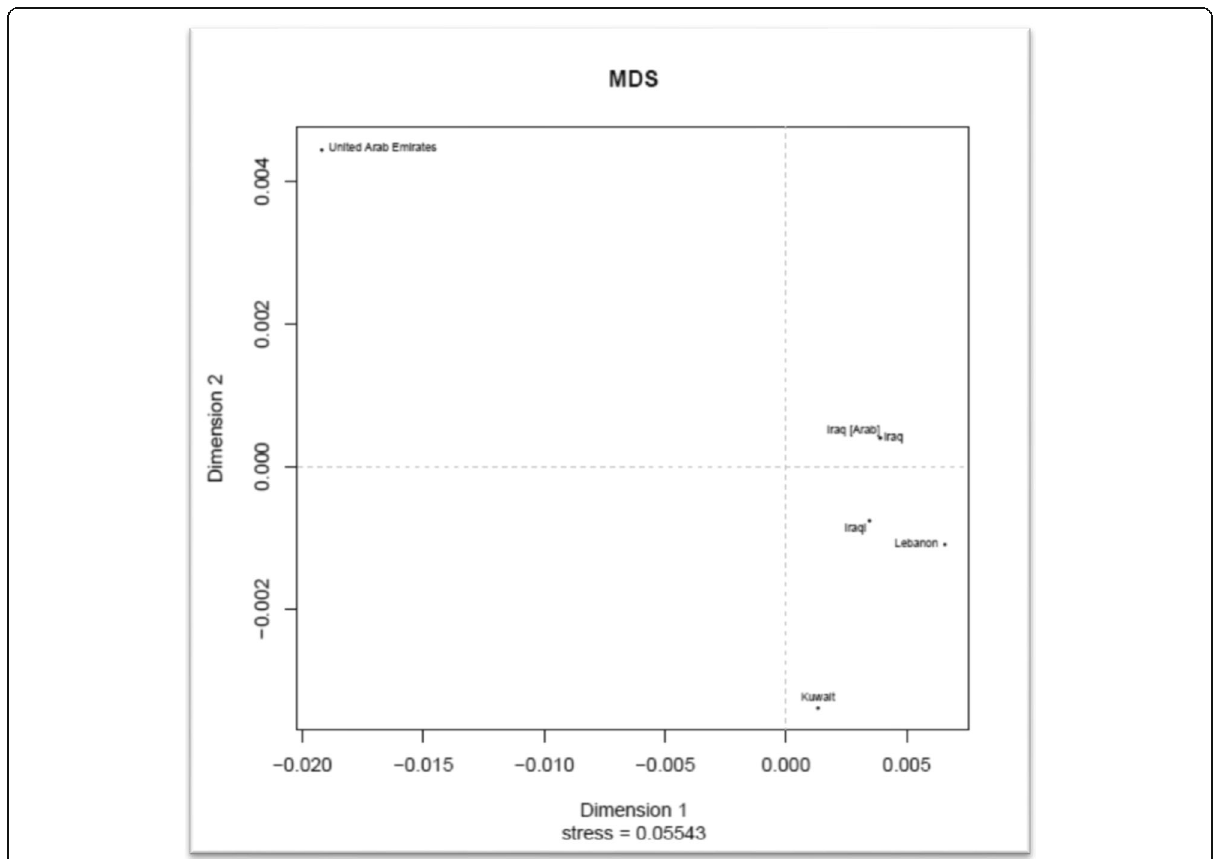
Fig. 1 Multi-dimensional scaling plot (MDS) based on pairwise Rst genetic distance values for Y-STR haplotypes for Iraqi haplotypes (current study) and other registered haplotypes of Iraqi population along with Lebanon, Kuwait, and United Arab Emirates